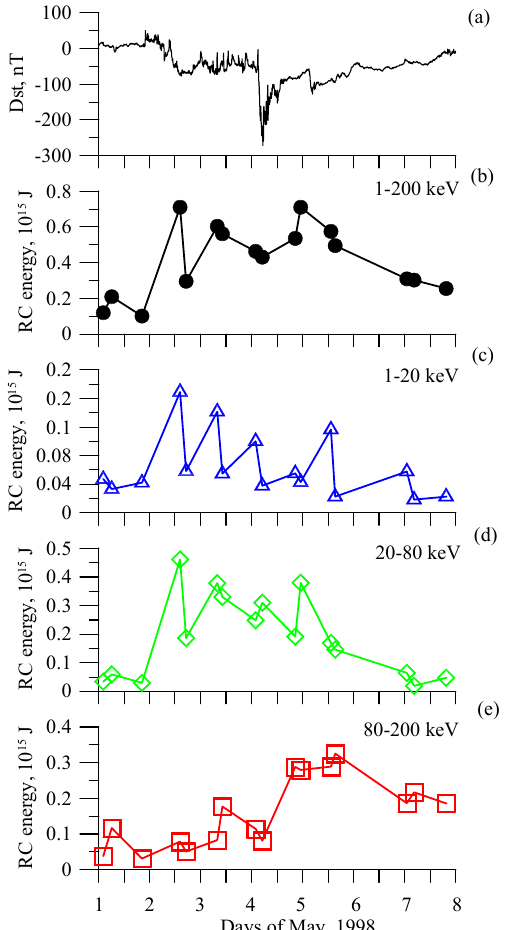
Fig. 4. Measured D st index ( a ) and calculated proton ring current energies using Polar CAMMICE/MICS measurements from ( b ) all (1–200keV), ( c ) low (1–20keV), ( d ) medium (20–80keV), and ( e ) high (80–200keV) energy protons during the period of 1–7 May